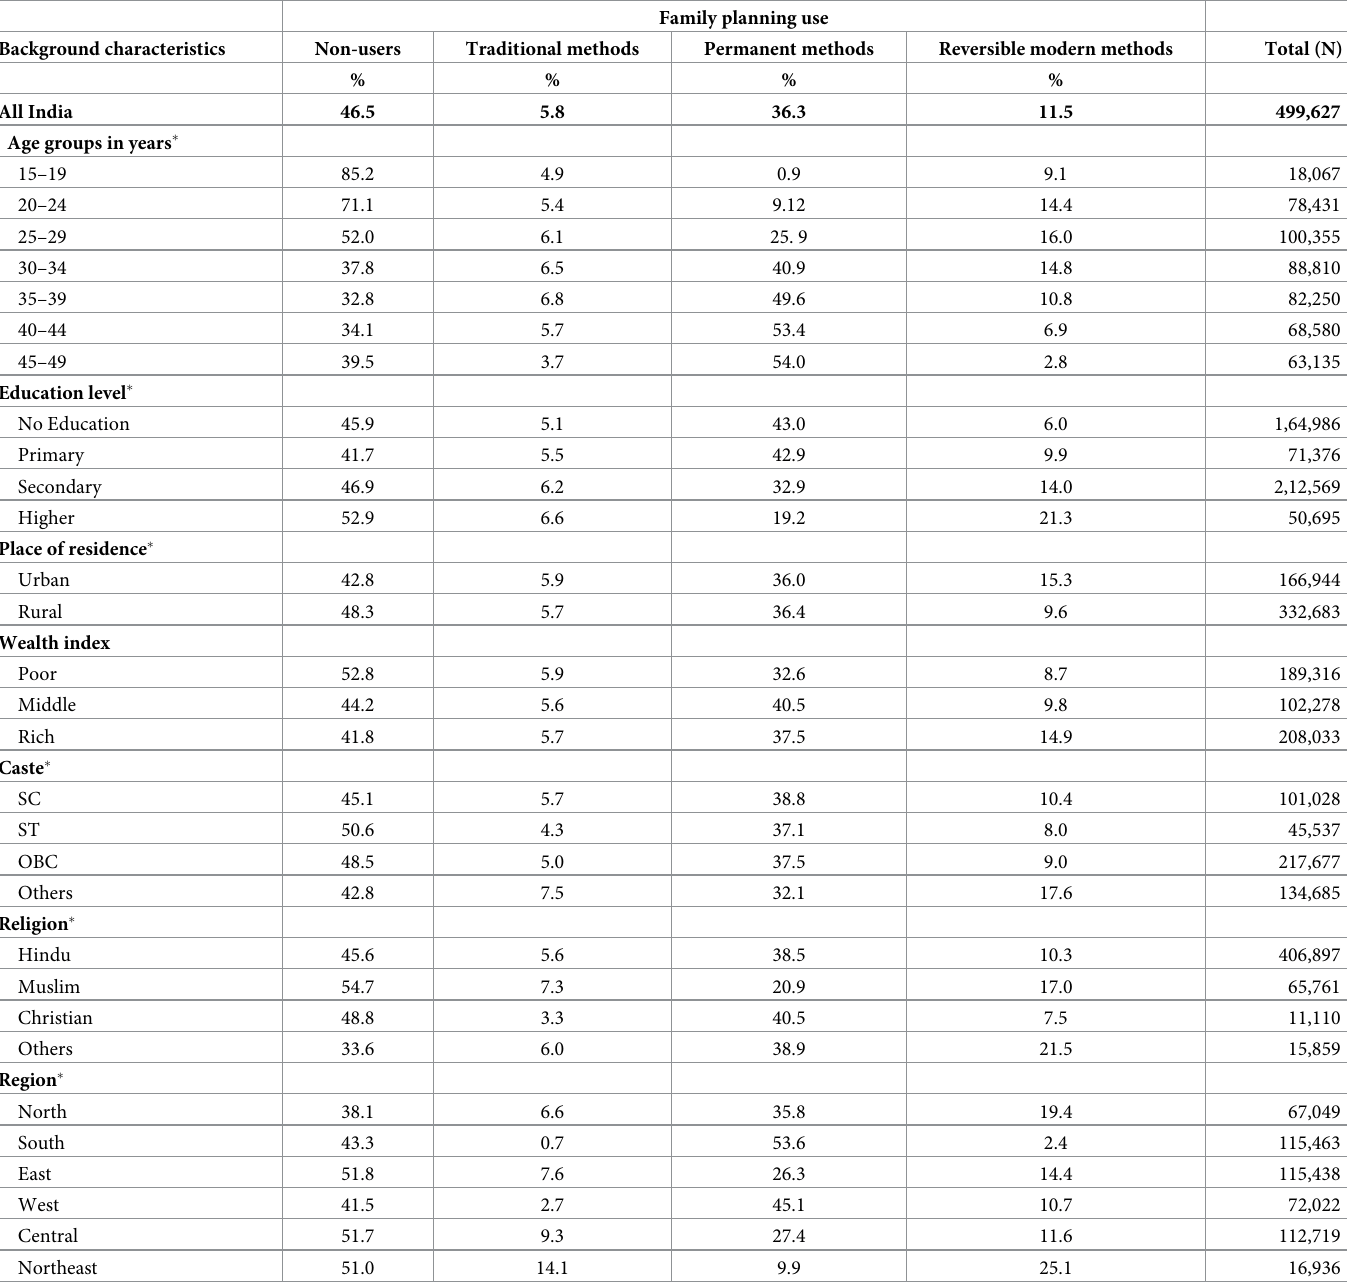
Table 2. Use of family planning methods by background characteristics for married women aged 15–49 years in India, NFHS 2015–16.